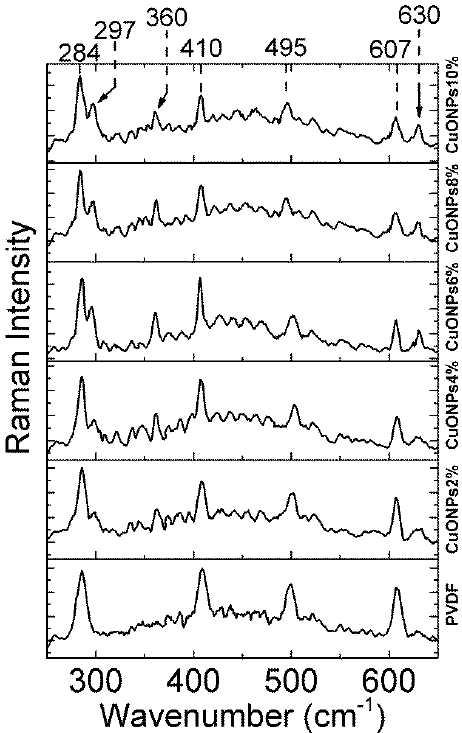
Figure 4. Raman spectra of the NWPET-PVDF membranes prepared at different copper oxide nanoparticles (CuONPs)/PVDF wt %.